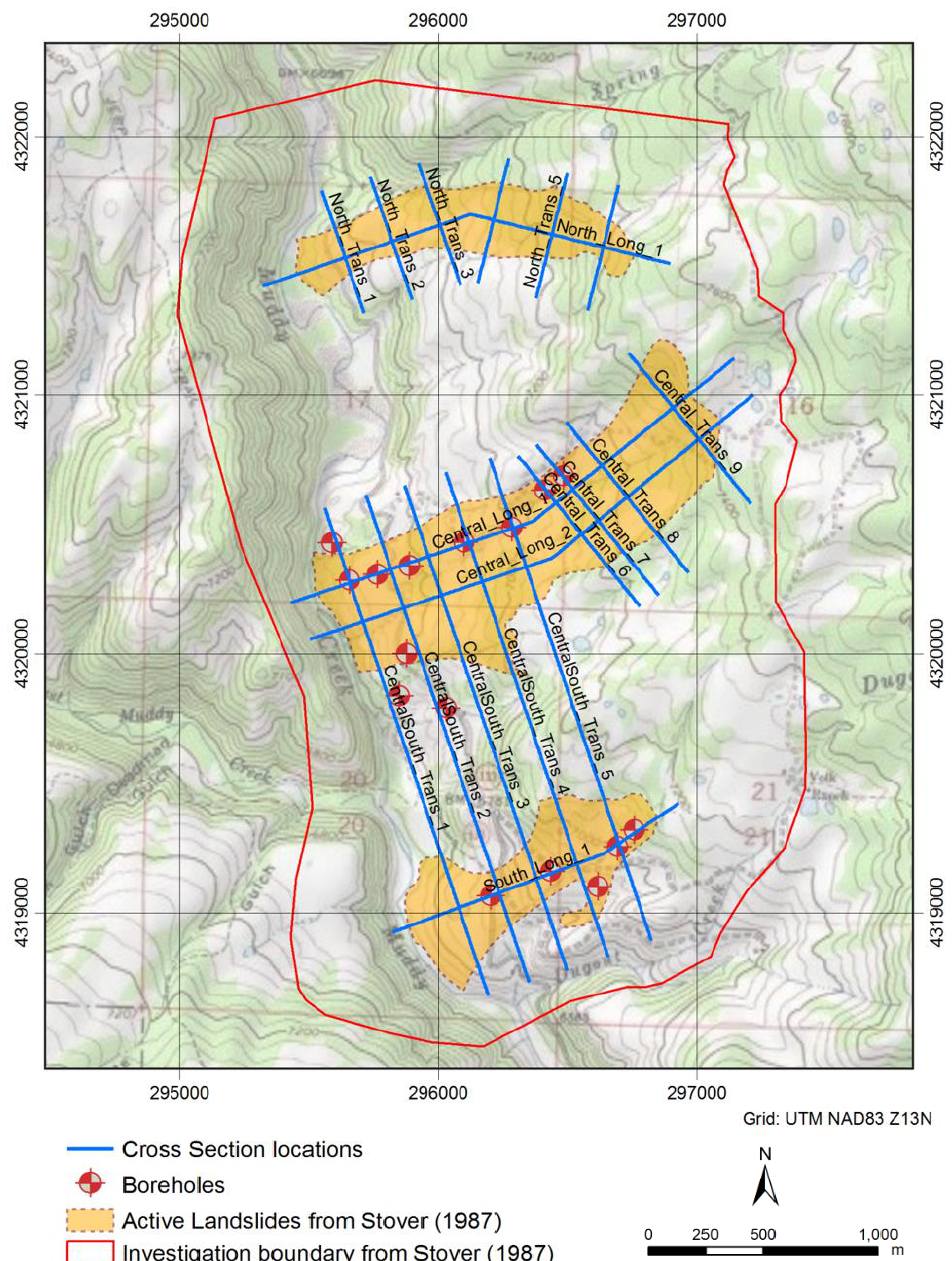
Figure 3. Locations of cross section and boreholes used to support subsurface modeling (modified from [2]).